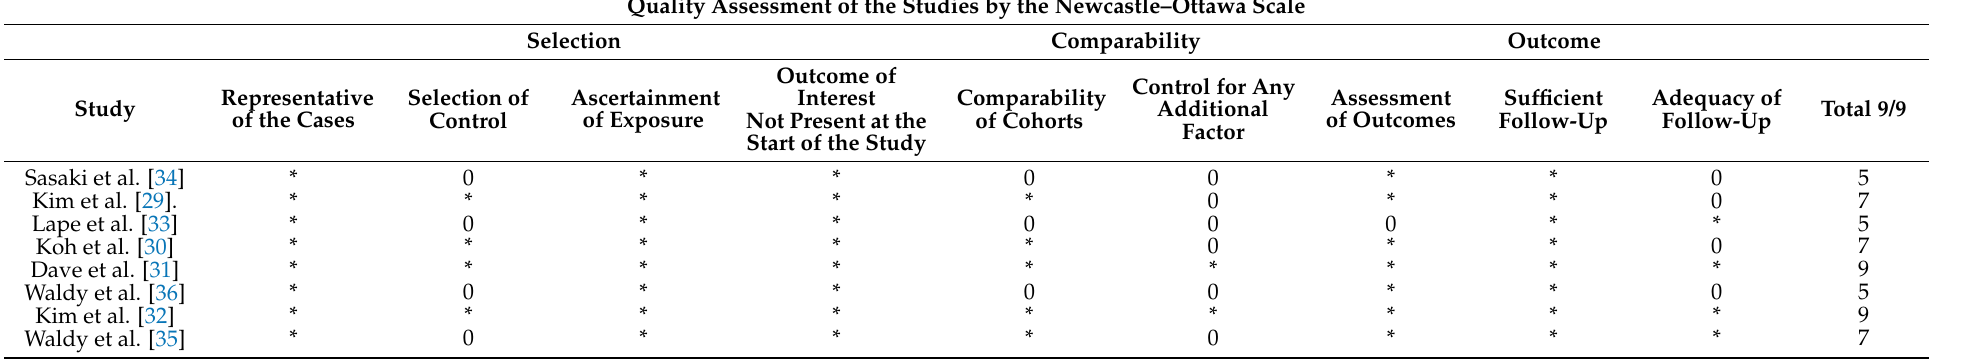
Table 3. Risk-of-bias assessment performed using the Newcastle–Ottawa